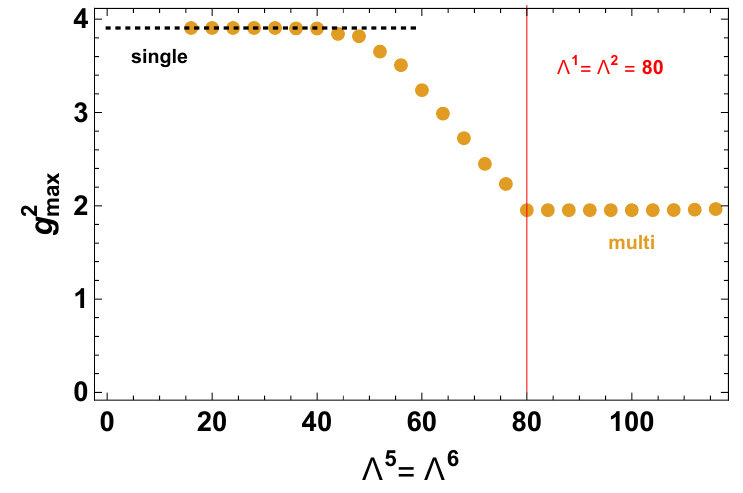
Figure 25. Bound on the maximal coupling (without any extrapolations) as a function of (cid:3) 5 = (cid:3) 6 for (cid:12)xed (cid:3) 1 = (cid:3) 2 = 80. We see that the multi-correlator bound does not improve over the single- correlator bound (in black) for a range of values of (cid:3) 5 = (cid:3) 6 , and this may lead one to believe that no improvement is possible whatsoever. On the other hand, increasing (cid:3) 5 = (cid:3) 6 above the